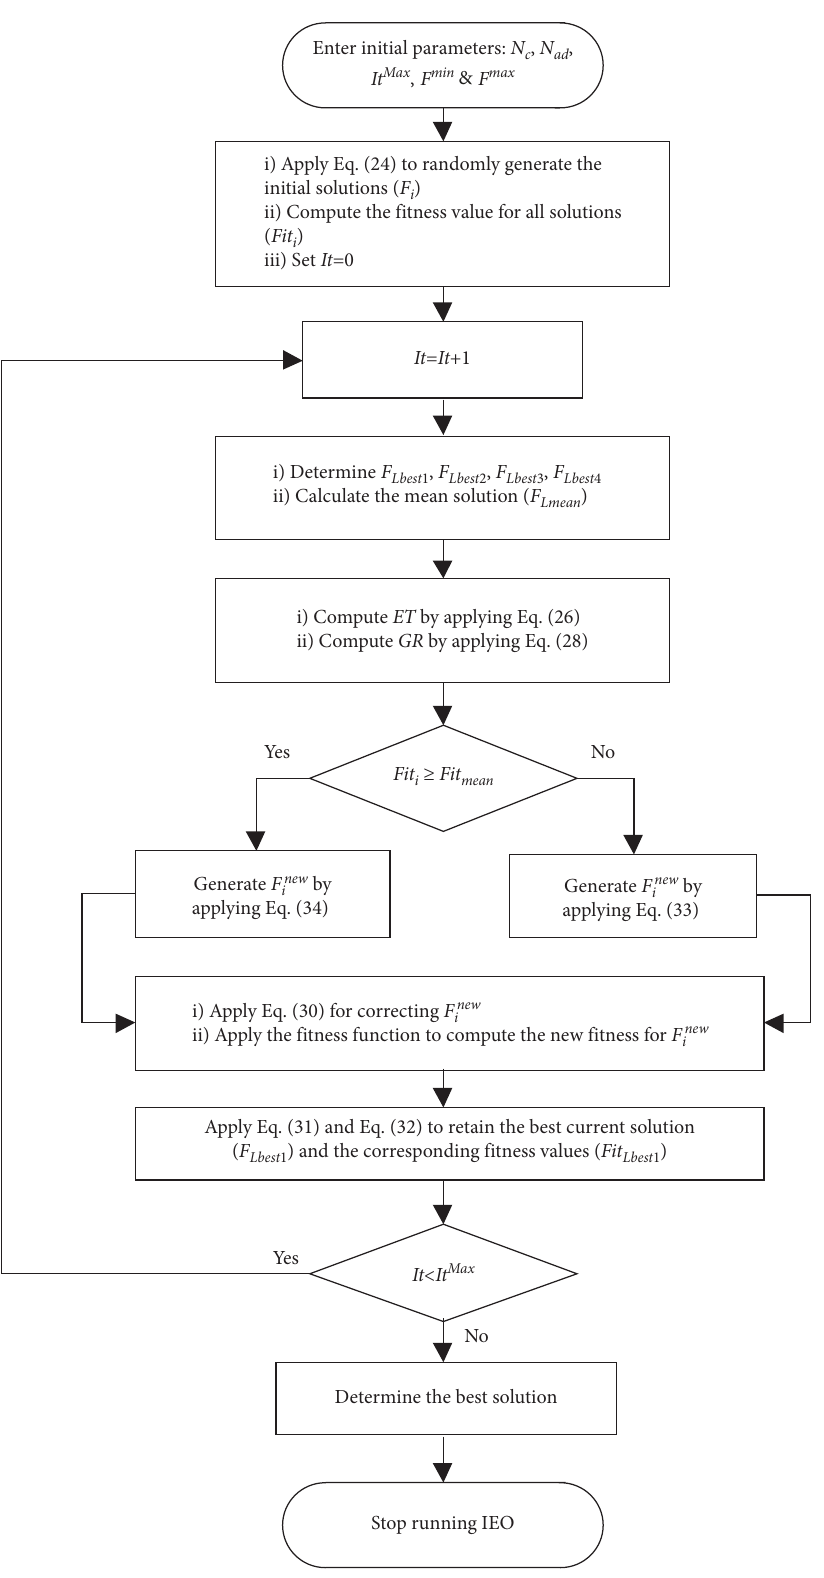
Figure 4: Te implementation process for the whole of IEO for the typical